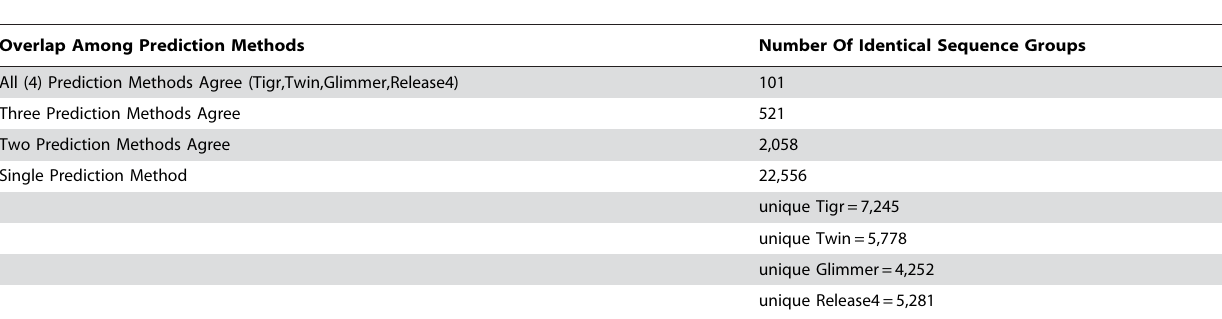
Table 3. Number of identical sequence groups containing one, two, three, or all four types (TigrScan, TwinScan, Glimmer, Release4) of protein prediction methods.